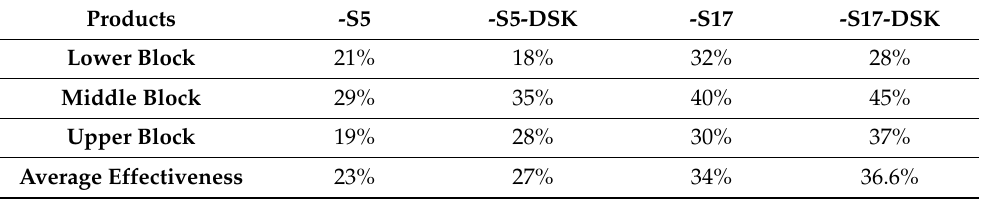
Figure 13. Double-size skids effect on temperature non-uniformities of products in ( a ) Config-1-S5, ( b ) Config-1-S17, ( c ) Config-2-S5, and ( d ) Config-2-S17. Table 4. Effect of the double-size skid on temperature non-uniformity reduction of blocks in Config-2 relative to